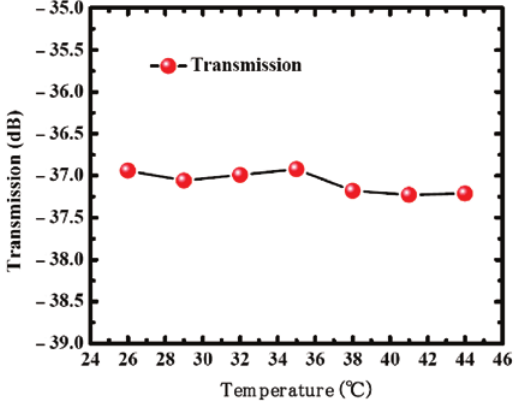
Figure 5: The relationship between transmission loss and applied magnetic field intensity.